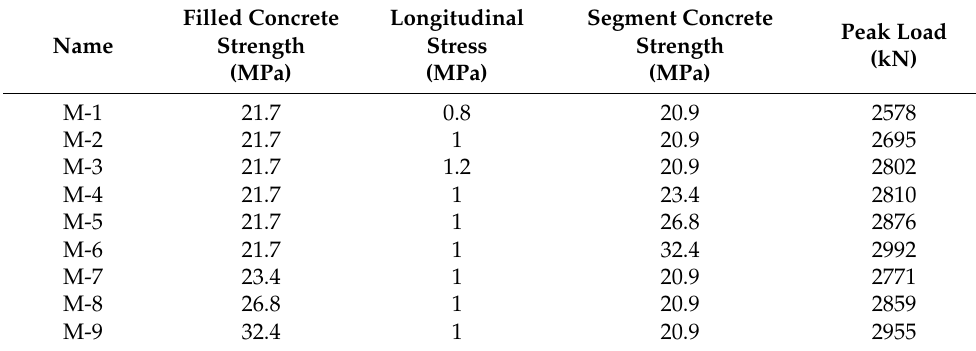
Table 8. Material parameters of the extended